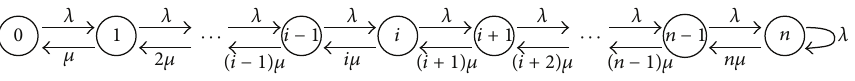
Figure 12: Markov chain model for the tunnel serving